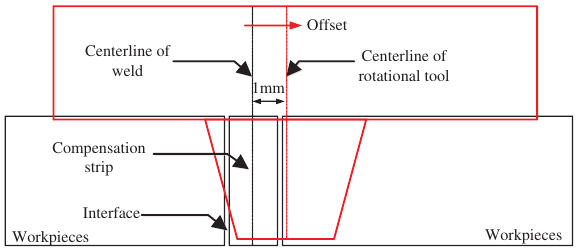
Figure 6: Schematic diagram of tool offset.